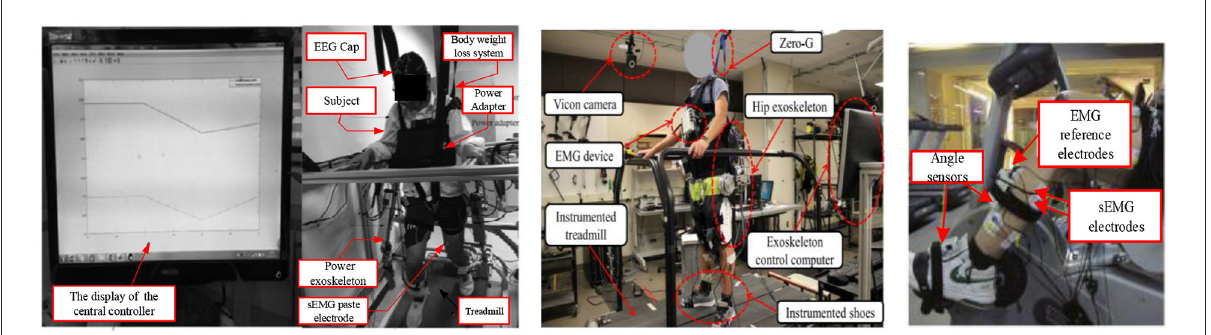
FIGURE8 (Left) The RT experiment, in which voluntary or active motor training is more effective than passive motor training in eliciting enhancements and cortical reconstruction (Gui et al., 2020). (Middle) Lab facilities for a human subject experimental protocol (Zhang et al., 2019d). (Right) EMG signals and joint angles acquisition during treadmill training from a non-disabled user (Zhang et al., 2012).